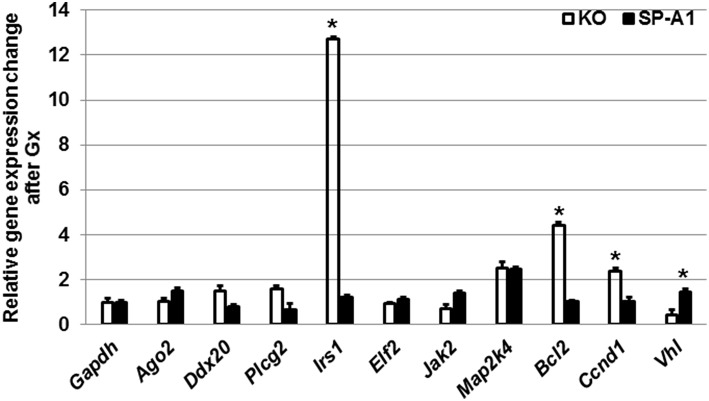
The effect of gonadectomy and OxS on genes that are targeted by the T2C miRNome. Genes were measured by qRT-PCR in KO and SP-A1 gonadectomized (Gx) male mice 4 h post O3 exposure and normalized to housekeeping gene Gapdh. The graph shows the relative expression changes of mRNAs Gx mice compared to non-gonadectomized. In the Gx KO the Irs1, Bcl2, and Ccnd1 expression levels were increased 13-, 4.5-, and 2.8-fold (p < 0.05), respectively. In the Gx SP-A1 the Vhl gene was significantly increased in SP-A1 by 1.8-fold. *means p < 0.05.